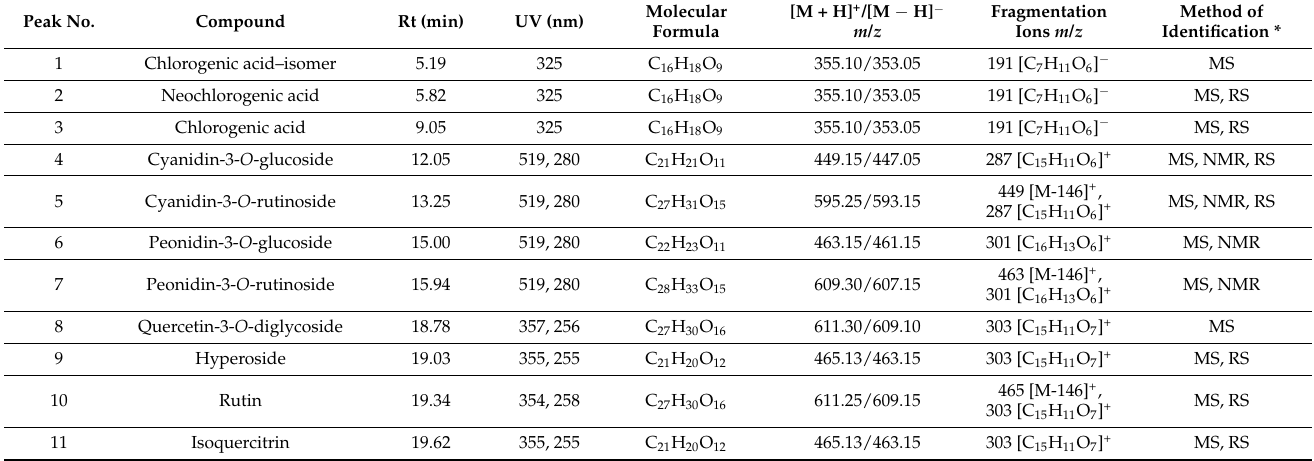
Table 3. LC–DAD–ESIMS analysis of the methanol extract of the fruit skins of the plum cultivar “ ˇCaˇcanska Lepotica” grown on GXN 15 rootstock.